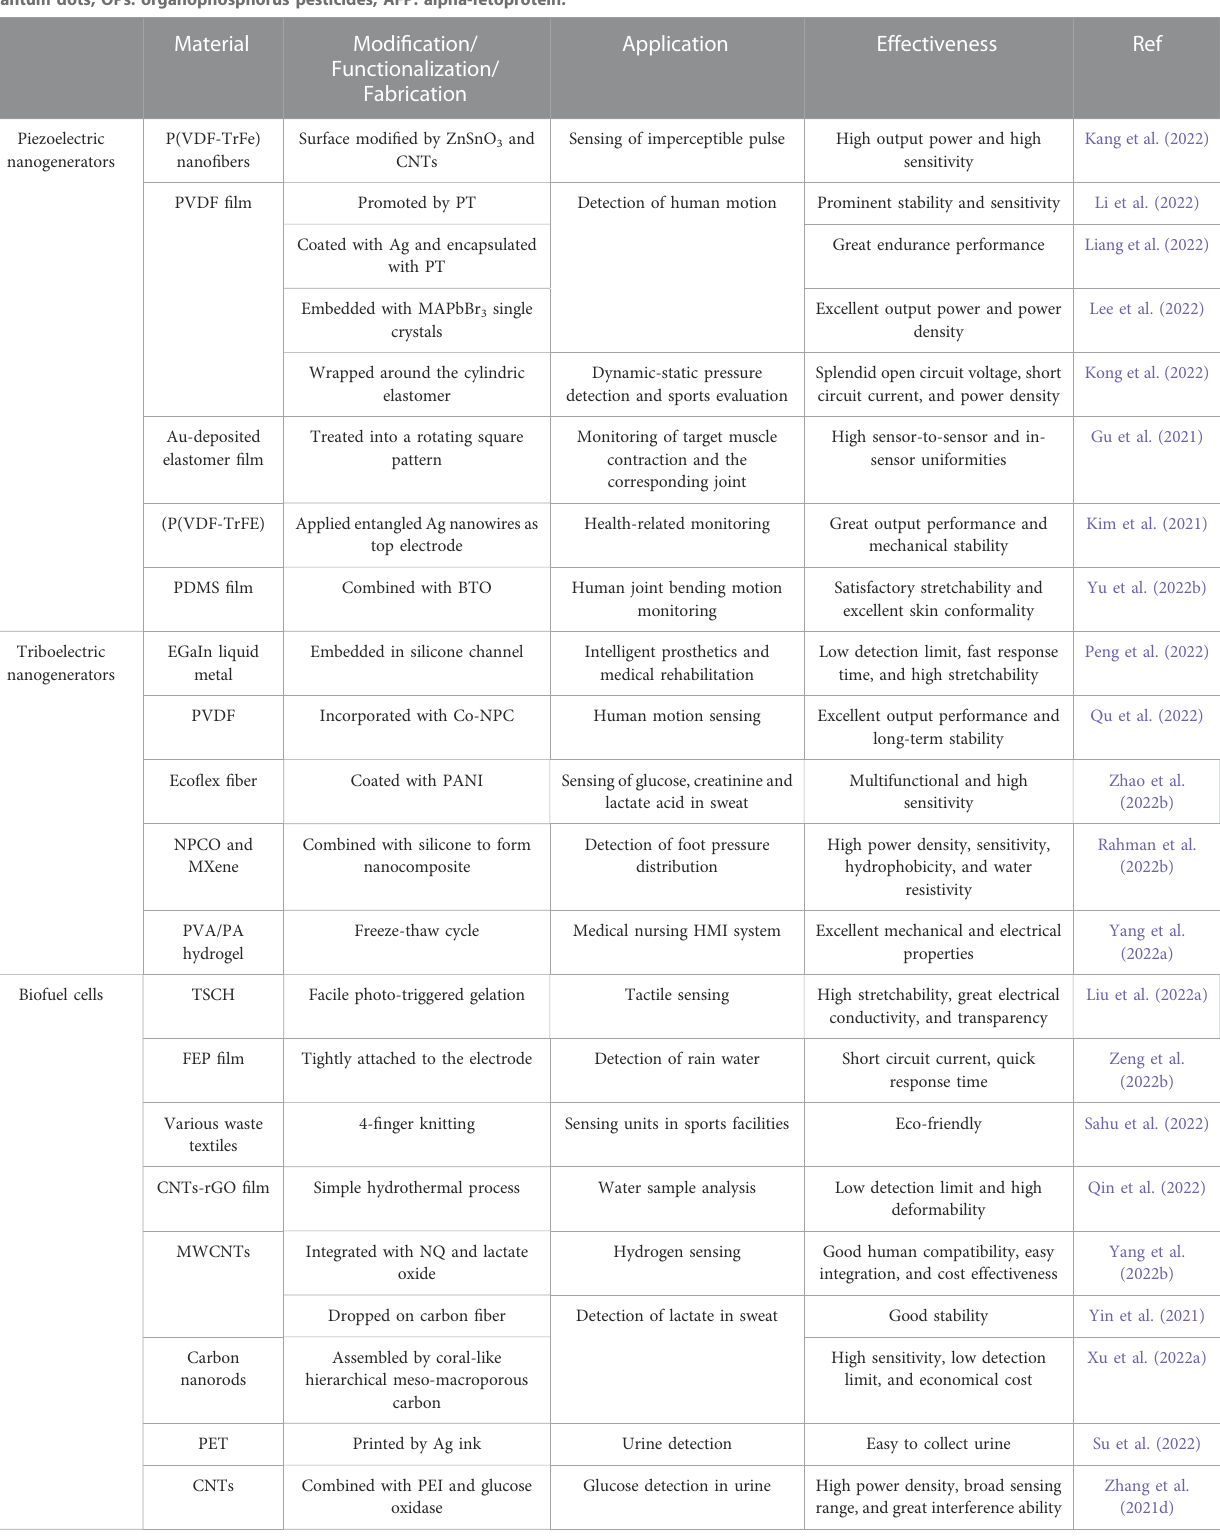
TABLE 1 Examples of self-powered technology towards wearable biosensors and biomedical applications. P(VDF-TrFe): poly (vinylidene fl uoride-co- tri fl uoroethylene); CNTs: carbon nanotubes; PVDF: polyvinylidene fl uoride; PT: polythiophene; MAPbBr 3 : Methylammonium lead tribromide; BTO: barium titanate;EGain:eutecticgallium-indium;Co-NPC:cobalt-basednanoporouscarbon;PANI:polyaniline;NPCO:nanoporouscobaltoxide;PVA/PA:polyvinylalcohol/ phyticacid;TSCH:transparent,stretchableandconductivehydrogel;FEP: fl uorinatedethylenepropylene;CNTs:carbonnanotubes;rGO:reducedgrapheneoxide; MWCNTs: multi-walled carbon nanotubes; NQ: naphthoquinone; PET: Polyethylene terephthalate; PEI: polyethyleneimine; NCQDs: nitrogen-doped carbon quantum dots; OPs: organophosphorus pesticides; AFP: